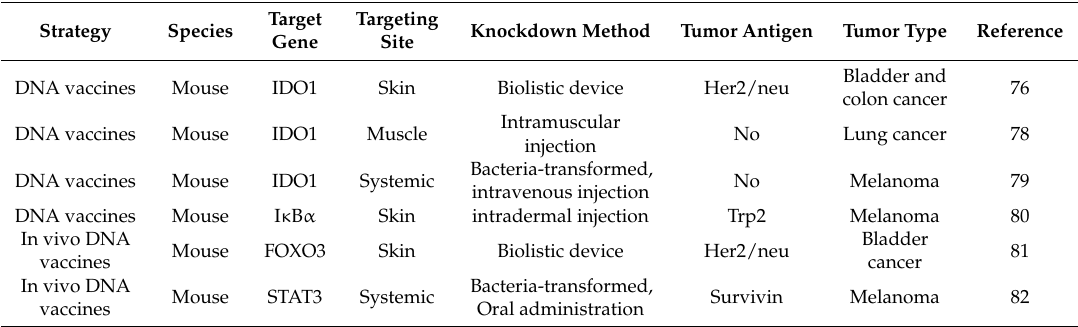
Table 2. In vivo silencing intracellular negative immune regulators of dendritic